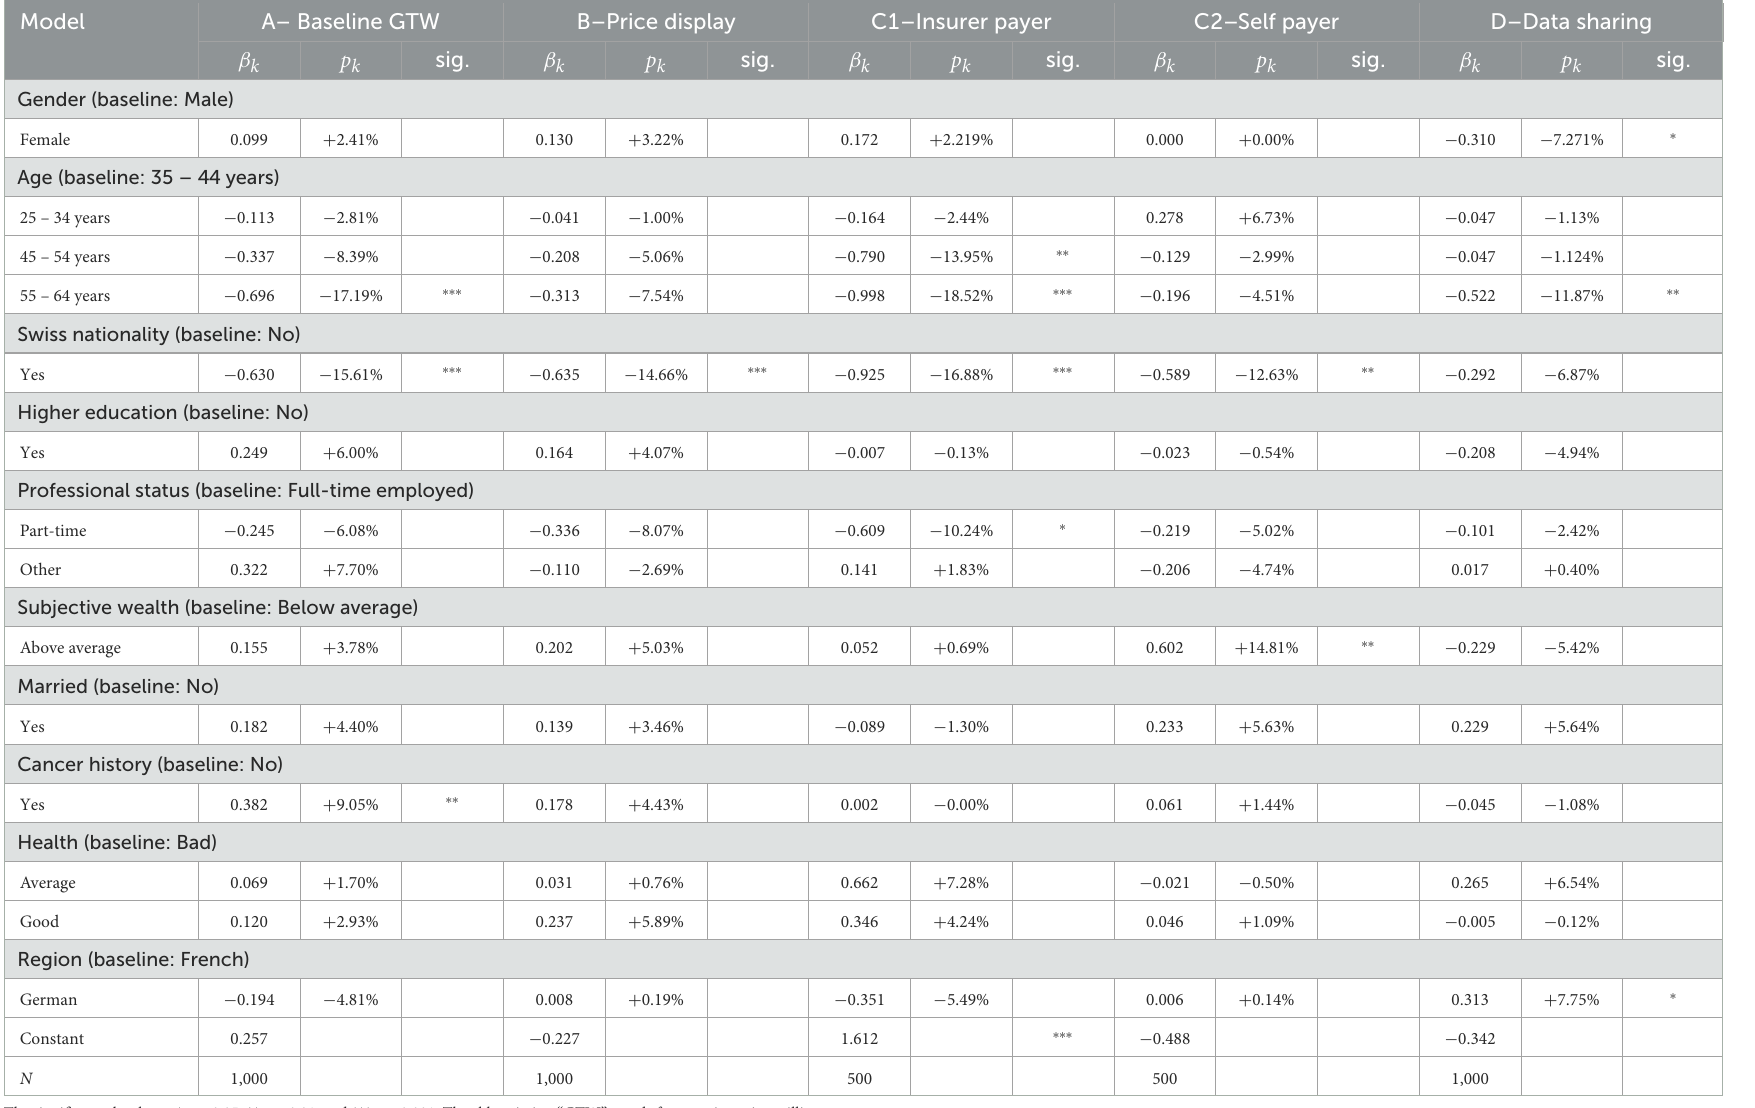
TABLE 5 Regression results for socioeconomic factors.